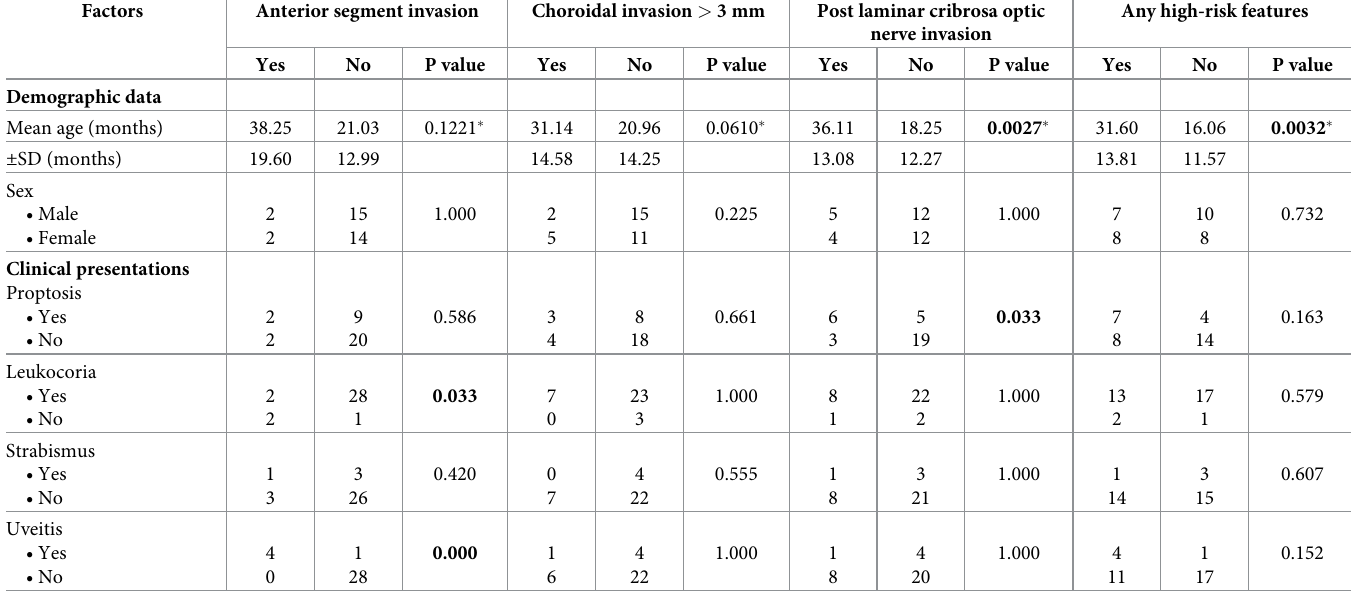
Table 5. The correlation between demographic data & clinical presentations and each type of high-risk histopathological features by using Fisher’s exact test and Mann–Whitney U test � . Factors